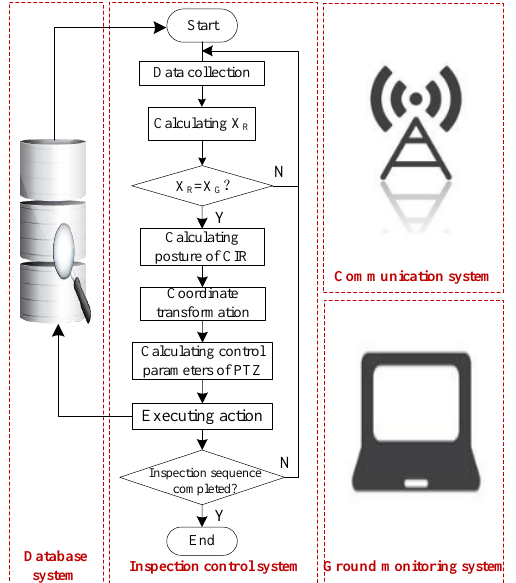
Figure 14. The block diagram of the inspection control.